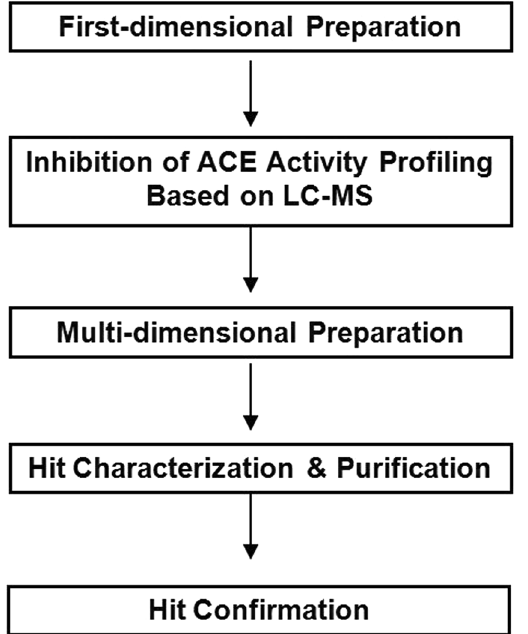
Figure 2. A LC/MS centric strategy for identifying active compounds from pine